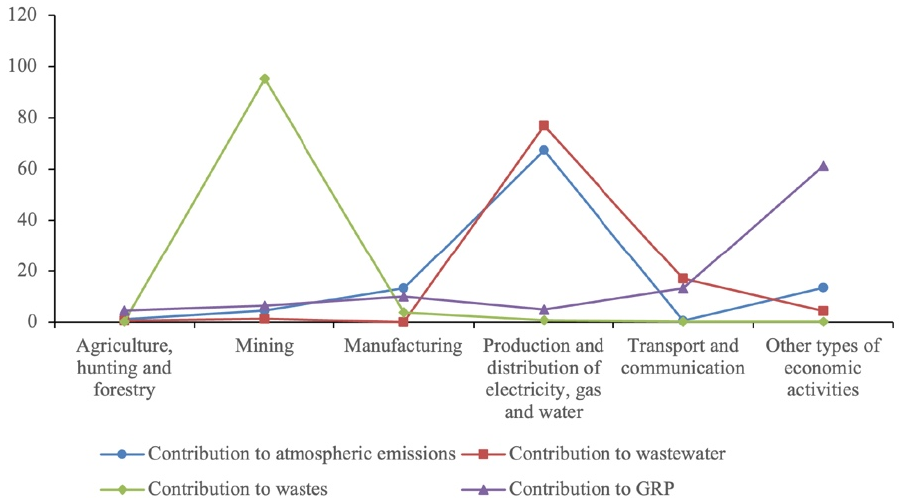
Figure 3. Industry contribution into pollution and GRP 2018, in percentages.